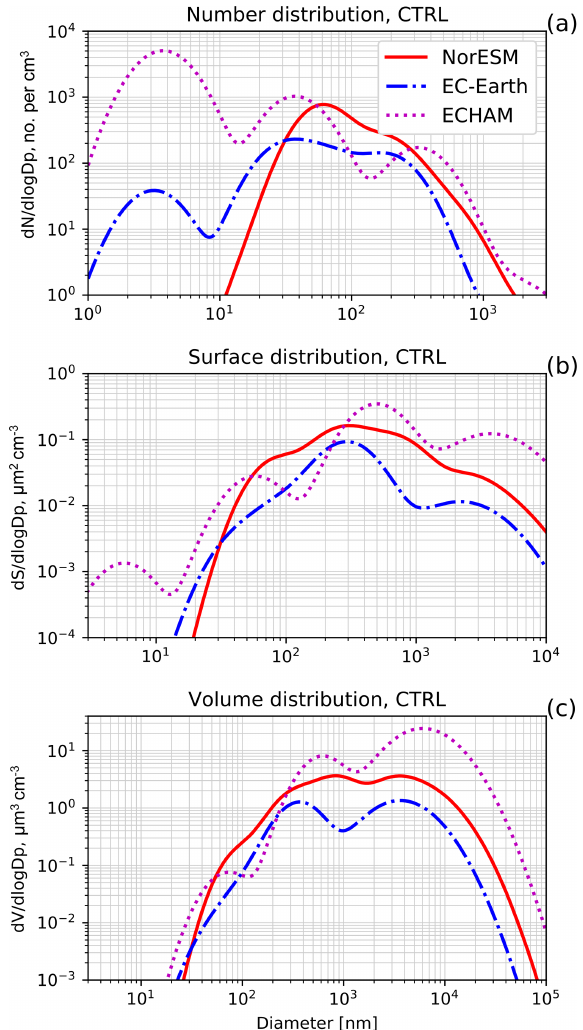
Figure 3. Globally averaged aerosol number size distributions (a) , surface size distributions (b) and volume size distributions from the three models from the CTRL simulation. The diameters are the dry diameters. Note the different scales on the x axis in the